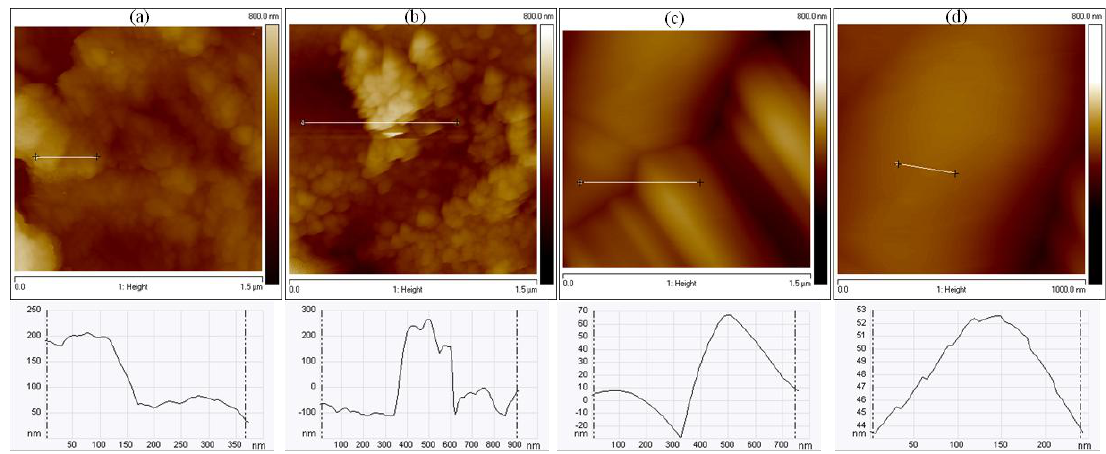
Figure 7. Atomic force microscopy images of samples C1 ( a ); C3 ( b ); and C2 ( c , d ). White line = profile traced to check the stacking of islands; result is shown in the chart below each image.